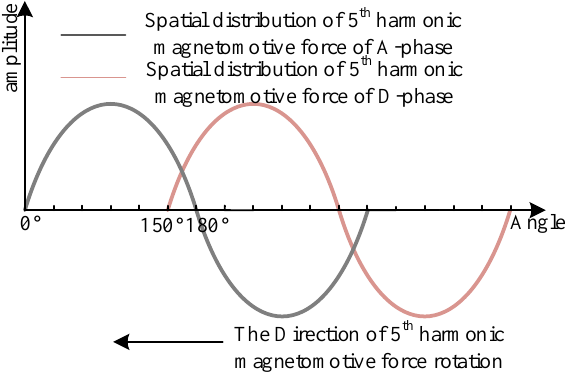
Figure 4. Spatial distribution of 5th harmonic magnetomotive force in two sets of windings.